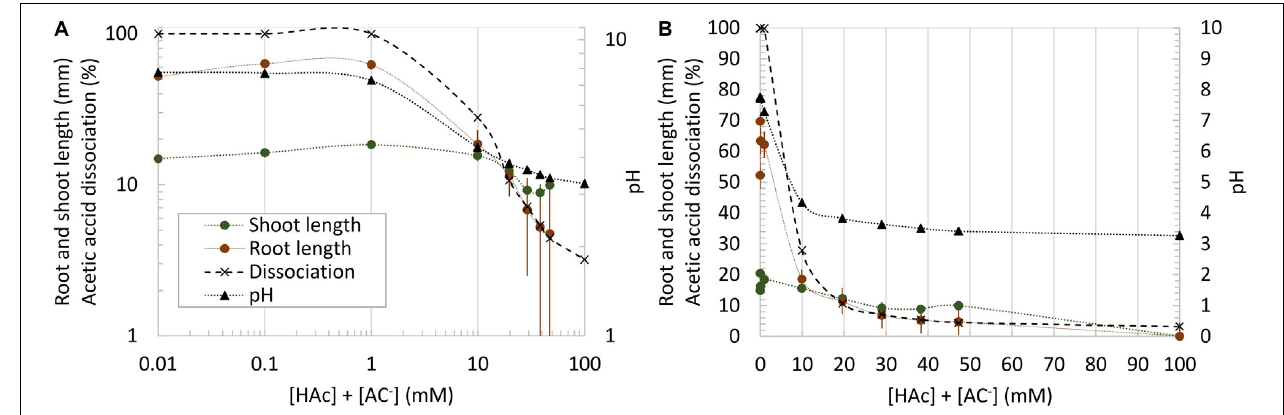
FIGURE 2 | Total (undissociated and dissociated) acetic acid concentration ([HAc] + [Ac − ]) impacts on seedling growth in germination paper rolls, along with pH and acetic acid dissociation. Mean root and shoot data ( ± 1 standard error; n = 6) are plotted both on a logarithmic (A) and linear (B)